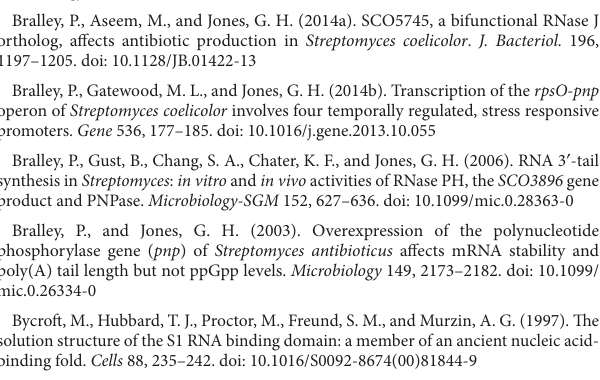
Figure 3 posits global regulators as one class of targets for Streptomyces RNases. In the case of RNase III for example, there may a single global regulator of act, red, cda and mmy production, whose transcript requires RNase III processing or degradation. That regulator, if it exists, remains elusive. Alternatively, it is possible that RNase III is involved in the processing of four different transcripts, each of which is required to produce one of the four S. coelicolor antibiotics. In similar fashion, any of the RNases discussed above might cleave the transcripts from any of the classes depicted in Figure 3, leading to inhibition or overproduction of antibiotics. It seems highly likely, although it is yet unproven, that RNase action on transcripts other than CSRs and other known regulators affects Streptomyces antibiotic production.